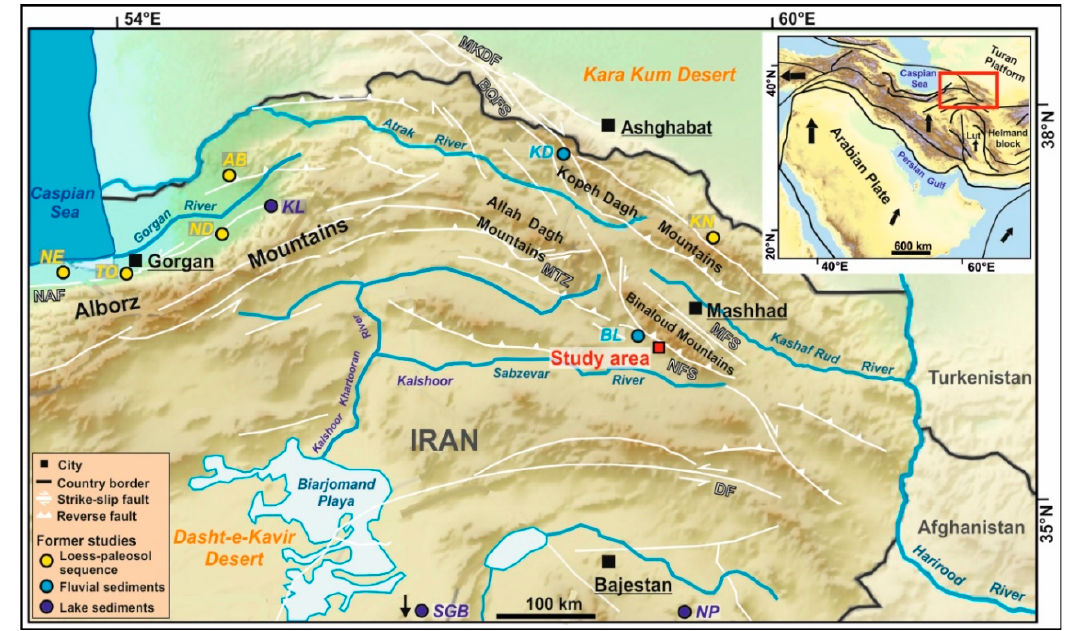
Figure 1. Overview of the study region in northeastern Iran with the regional tectonic setting (taken from [36]). The study area in the southwestern Binaloud Mountains is marked with a red rectangle, and the sites of former paleoenvironmental studies with coloured circles (Loess-paleosol sequences: NE = Neka, TO = Toshan, ND = Now Deh, AB = Agh Band [32–34], KN = Kalat-e-Naderi [31]; Fluvial sediments: KD = Kopeh Dagh [37], BL = Binaloud Mountains [38]; Lake sediments: NP = Nimbluk Plain [27], SGB = South Golbaf Basin [26], KL = Kongor Lake [39]). BQFS = Bakharden-Quchan Fault System, DF = Doruneh Fault, MTZ = Meshkan Transfer Zone, MFS = Mashhad Fault System, MKDF = Main Kopeh Dagh Fault, NAF = North Alborz Fault, NFS = Neyshabour Fault System. The study region in northeastern Iran in a larger regional tectonic context [36]. Map sources: Digital Elevation Model GTOPO30 (https://earthexplorer.usgs.gov) and Digital Elevation Model ALOS PALSAR (https://vertex.daac.asf.alaska.edu).